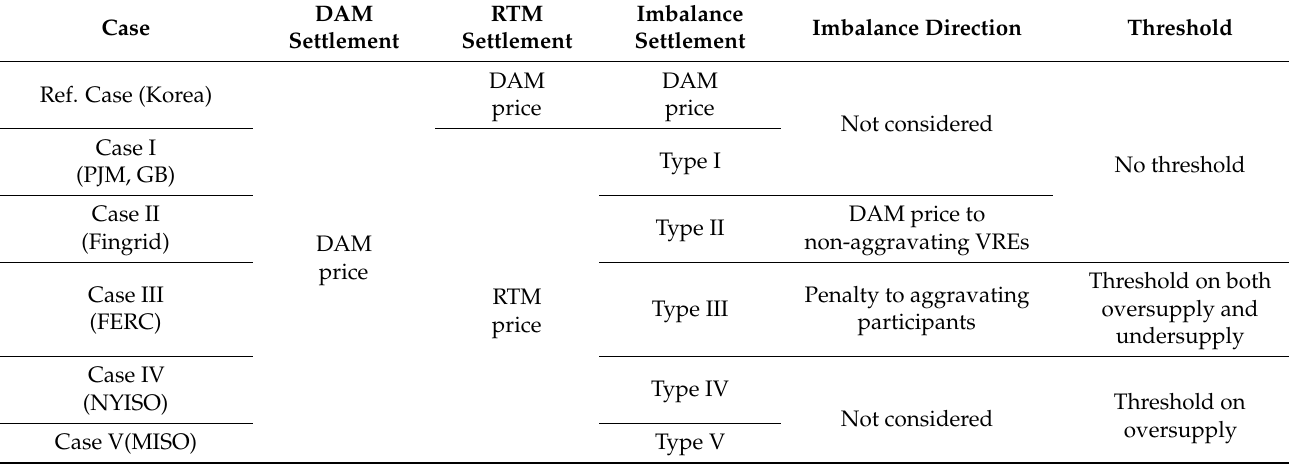
Table 3. Summary of each pricing